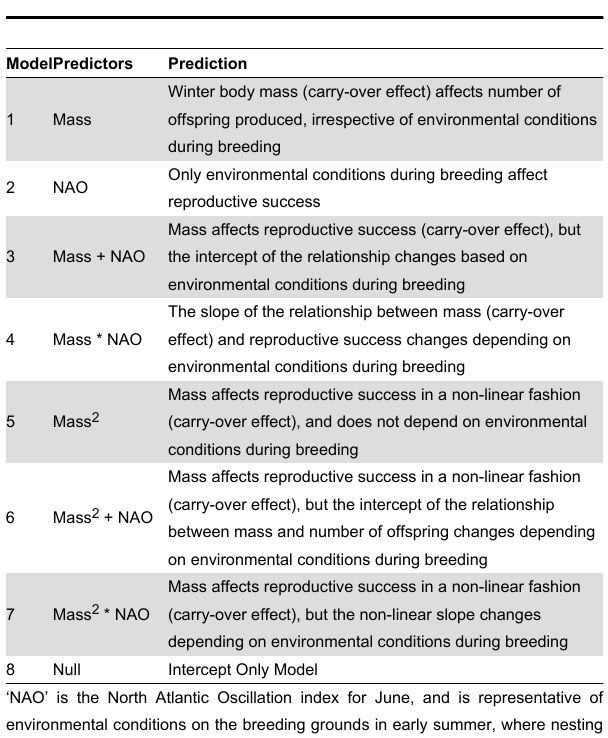
Table 1. Eight competing models investigating the factors affecting the reproductive success of light-bellied Brent geese, measured as number of offspring females returned to the wintering grounds following Autumn migration from the breeding quarters in the Canadian High